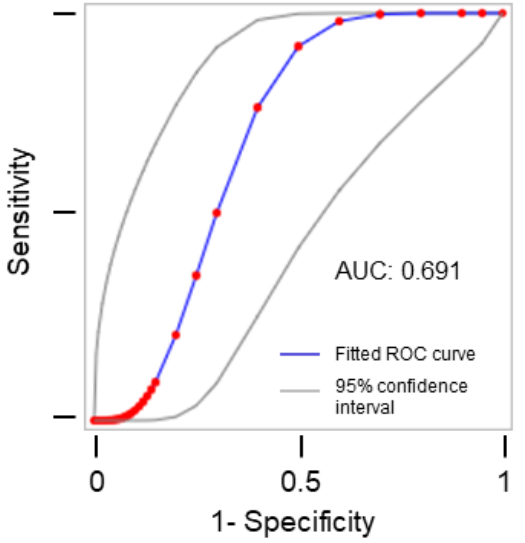
Figure 2. Receiver operating characteristic (ROC) curve for the diagnostic performance of volumetry as a predictor of overall postoperative complications. AUC: area under the curve.